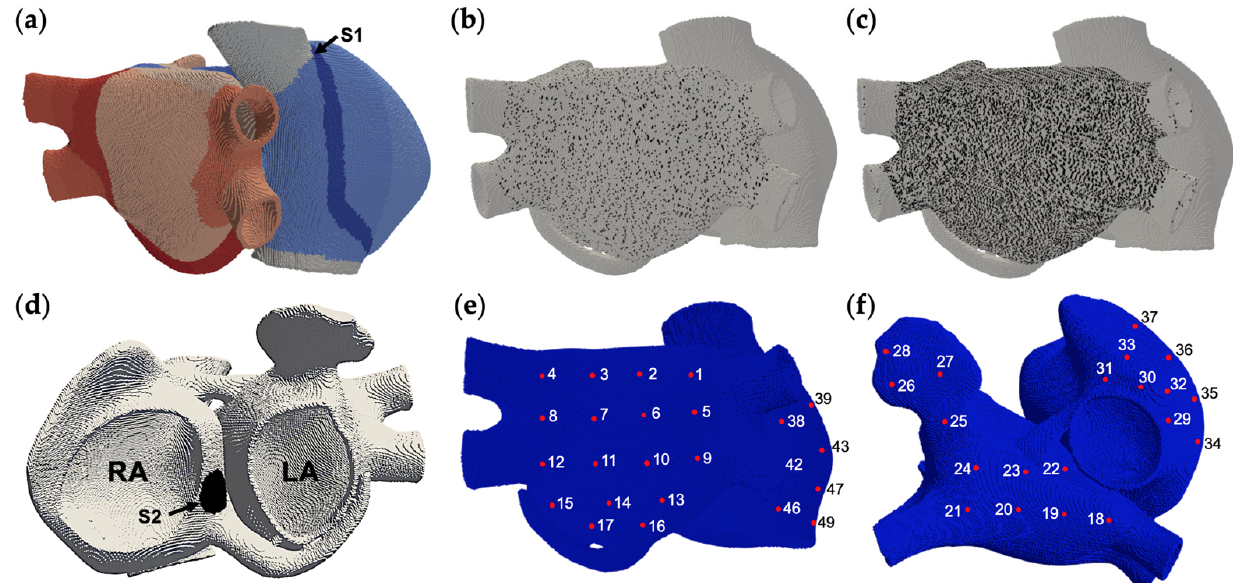
Figure 1. The 3D model of human atria. ( a ) Atrial regions with heterogeneity and sinoatrial node (S1) are shown. The fibrosis distribution in the left atrium is shown at densities of ( b ) 6.25% (low) and ( c ) 25% (high). ( d ) Ectopic focus location (S2), where right (RA) and left (LA) atrium are indicated. ( e , f ) 50 virtual electrodes locations.